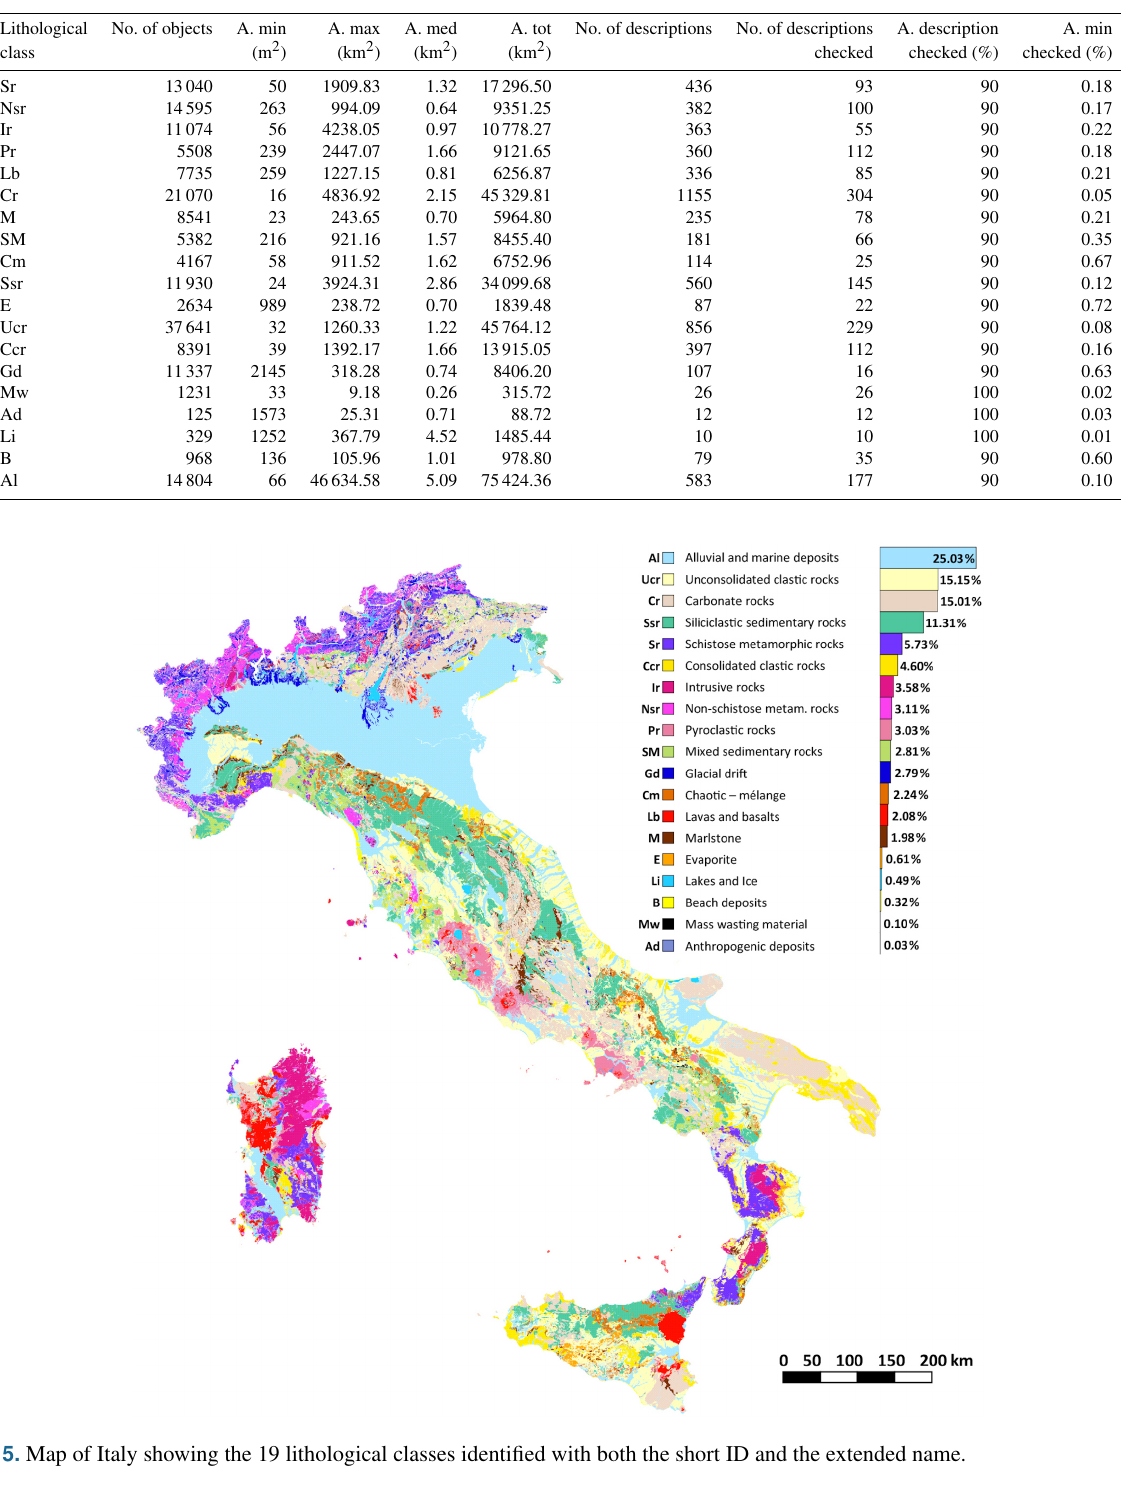
Table 3. Descriptive statistics of the 19 lithological classes. In the left half of the table, the number of polygons and their minimum, maximum, average, and total area for each lithological class are shown. The right half of the table shows the number of total unique descriptions and those checked during the technical validation in relation to the percentage of the area covered by the validation (% of the total area) and the detail of the validation (minimum area checked).